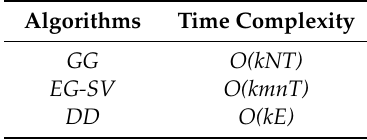
Table 1. Time complexities of algorithms in this paper.